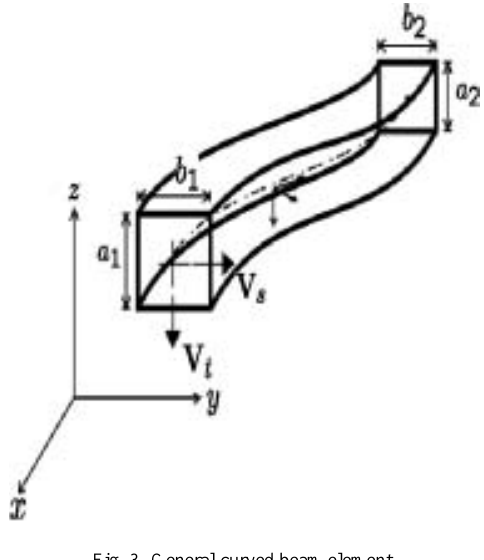
Fig. 3. General curved beam